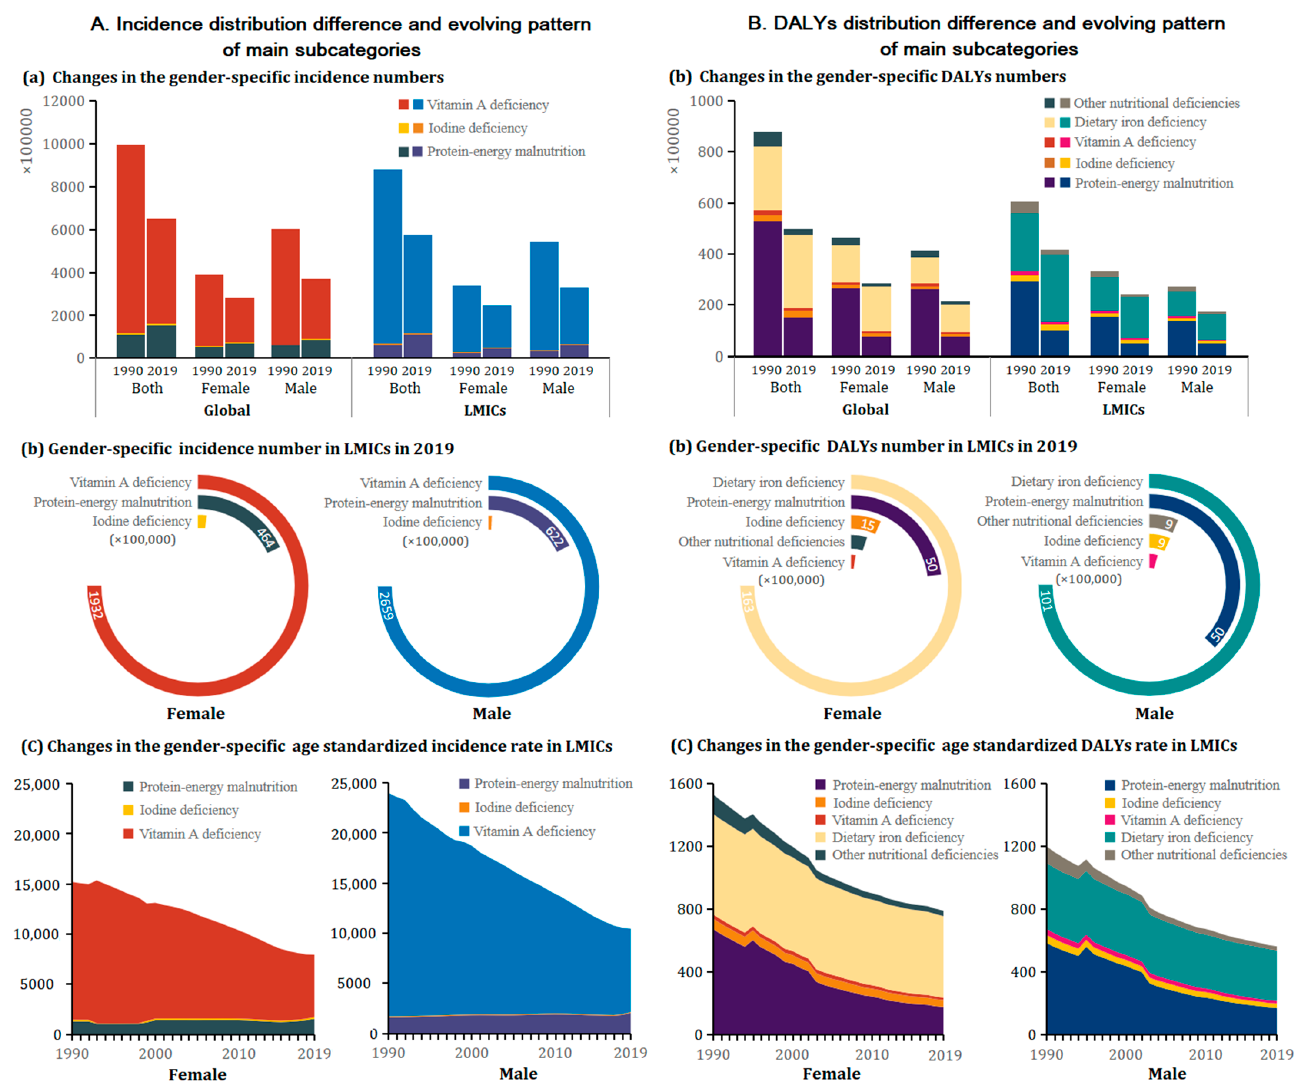
Figure 2. The sex ‐ specific incidence and DALYs counts and age ‐ standardized rate for main subcae ‐ gories in LMICs from 1990 to 2019, and their contribution to the global burden. ( A ) Incidence; ( B ) DALYs. DALYs = disability ‐ adjusted life years.